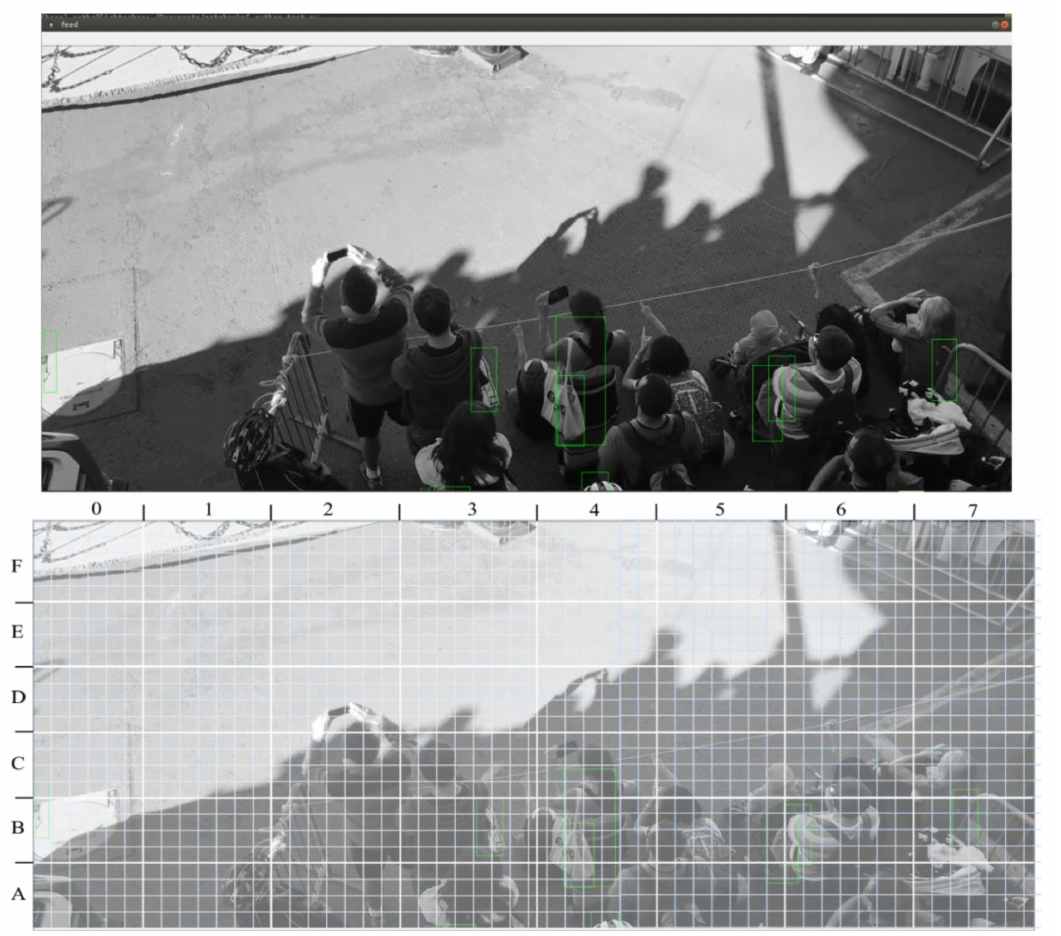
Figure 4. Another video frame of the test stream labeled into